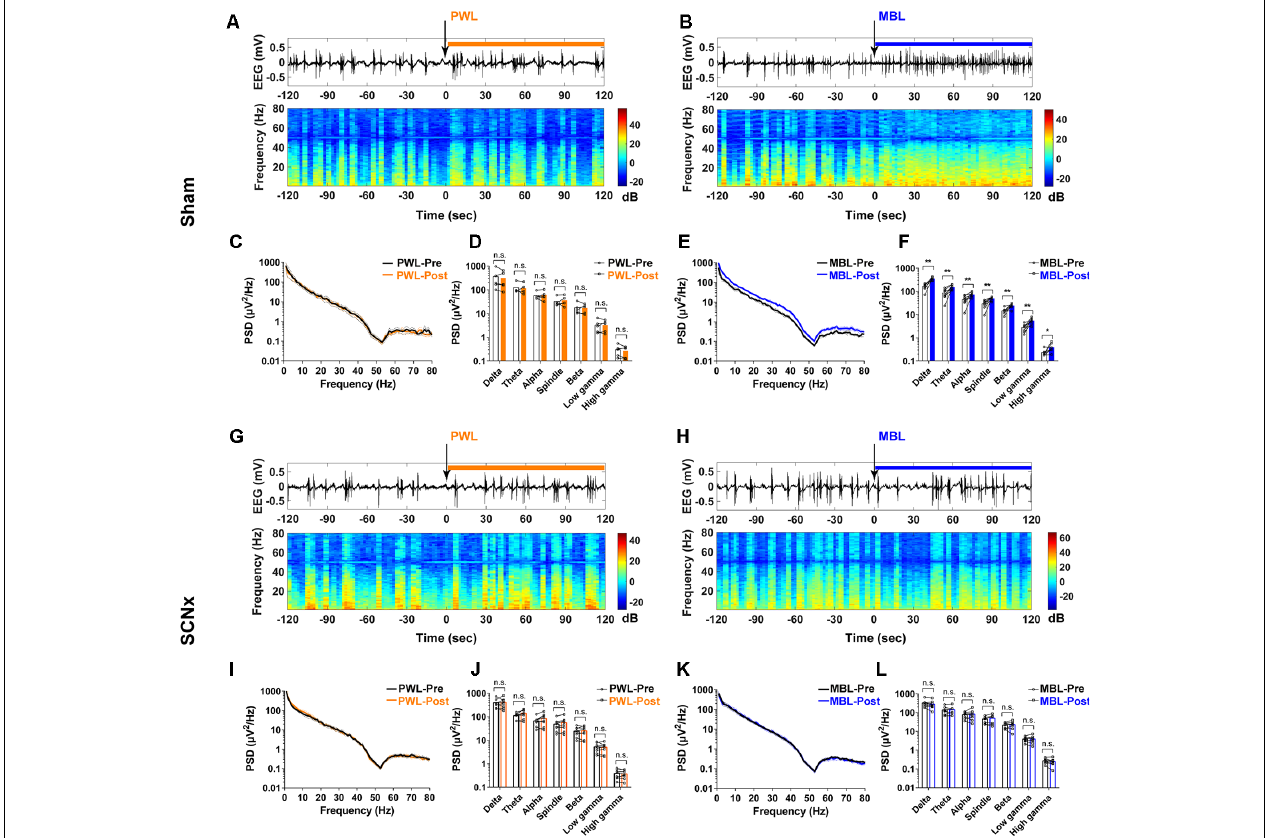
FIGURE 6 | Lesion of SCN neurons eliminated the increase in cortical EEG activity induced by MBL during continuous inhalation of 2.5% sevoflurane. (A,B) Representative electroencephalogram traces (upper) and electroencephalogram power spectrogram (lower) in the sham group-administered PWL (A) or MBL (B) . Time 0 indicates the beginning of light stimulation during continuous sevoflurane anesthesia. The orange and blue lines indicate the 120 s intervals used for power spectral density comparisons. (C) PSD in the sham mice computed from 2 min before PWL (black) and 2 min after PWL (orange). (D) The sham mice treated with PWL showed no statistically significant difference in electroencephalogram power compared to sham pre-PWL (n.s. = not significant compared with sham pre-PWL, n = 5, paired Student’s t -tests). (E) PSD in the sham mice computed from 2 min before MBL (black) and 2 min after MBL (blue). (F) The sham mice treated with MBL showed increased electroencephalogram power in all of the frequency bands compared to sham pre-MBL (* p < 0.05 and ** p < 0.01 compared with sham pre-MBL, n = 8, and paired Student’s t -tests). (G,H) Representative electroencephalogram traces (upper) and electroencephalogram power spectrogram (lower) in the SCNx group-administered PWL (G) or MBL (H) . Time 0 indicates the beginning of light stimulation during continuous sevoflurane anesthesia. The orange and blue lines indicate the 120 s intervals used for power spectral density comparisons. (I) PSD in the SCNx mice computed from 2 min before PWL (black) and 2 min after PWL (orange). (J) The SCNx mice treated with PWL showed no statistically significant difference in electroencephalogram power compared to SCNx pre-PWL (n.s. = not significant compared with SCNx pre-PWL, n = 8, and paired Student’s t -tests). (K) PSD in the SCNx mice computed from 2 min before MBL (black) and 2 min after MBL (blue). (L) The SCNx mice treated with MBL showed no statistically significant difference in electroencephalogram power compared to SCNx pre-MBL (n.s. = not significant, compared with SCNx pre-MBL, n = 8, and paired Student’s t -tests). PWL, polychromatic white light; MBL, monochromatic blue